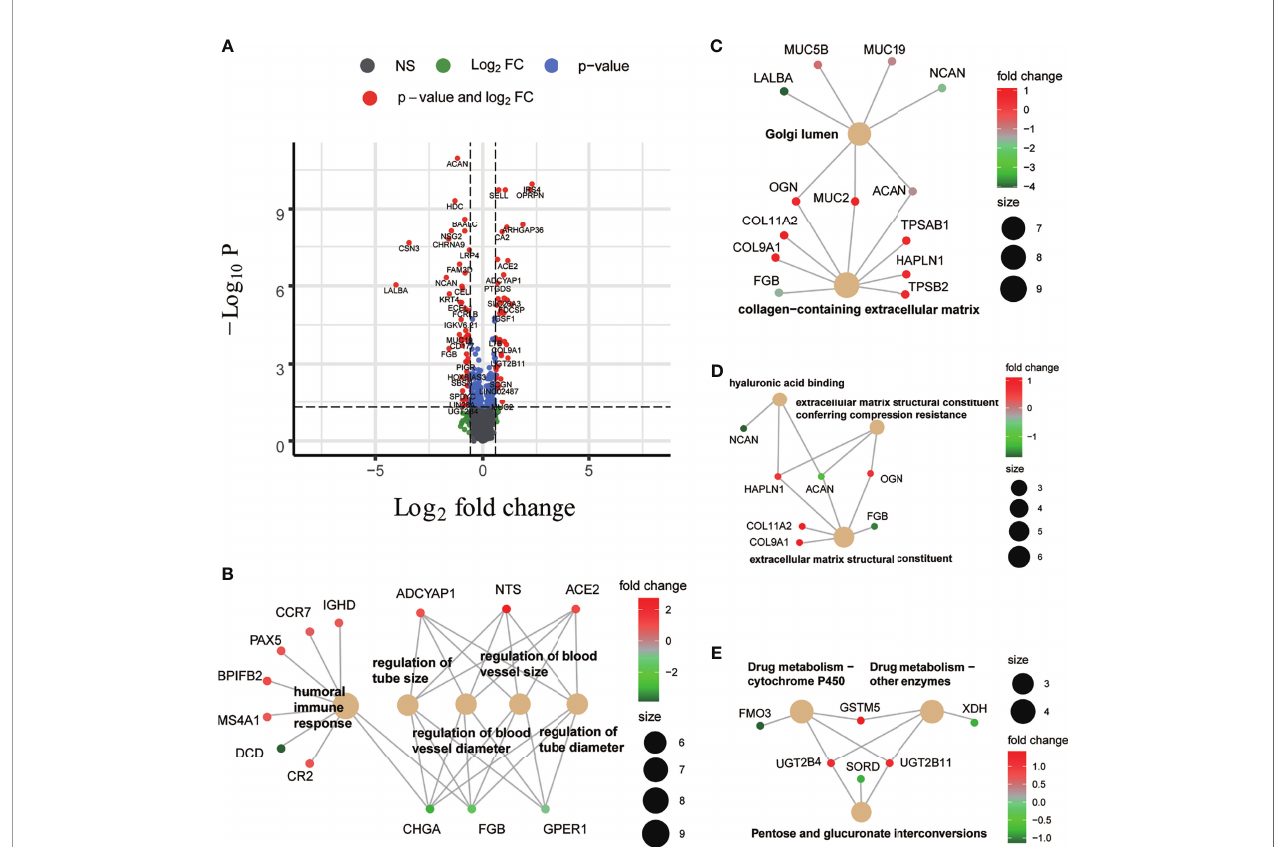
FIGURE 4 | Differentially expressed genes (DEGs) between two BC-CMS and associated functional enrichment analyses. (A) Volcano plot depicting the differentially expressed genes with FC >1.5 and FDR <0.05. (B) Biological process (BP) enrichment analysis on DEGs. (C) Cellular component enrichment analysis on DEGs. (D) Molecular function enrichment analysis on DEGs. (E) Kyoto Encyclopedia of Genes and Genomes pathway enrichment analysis on